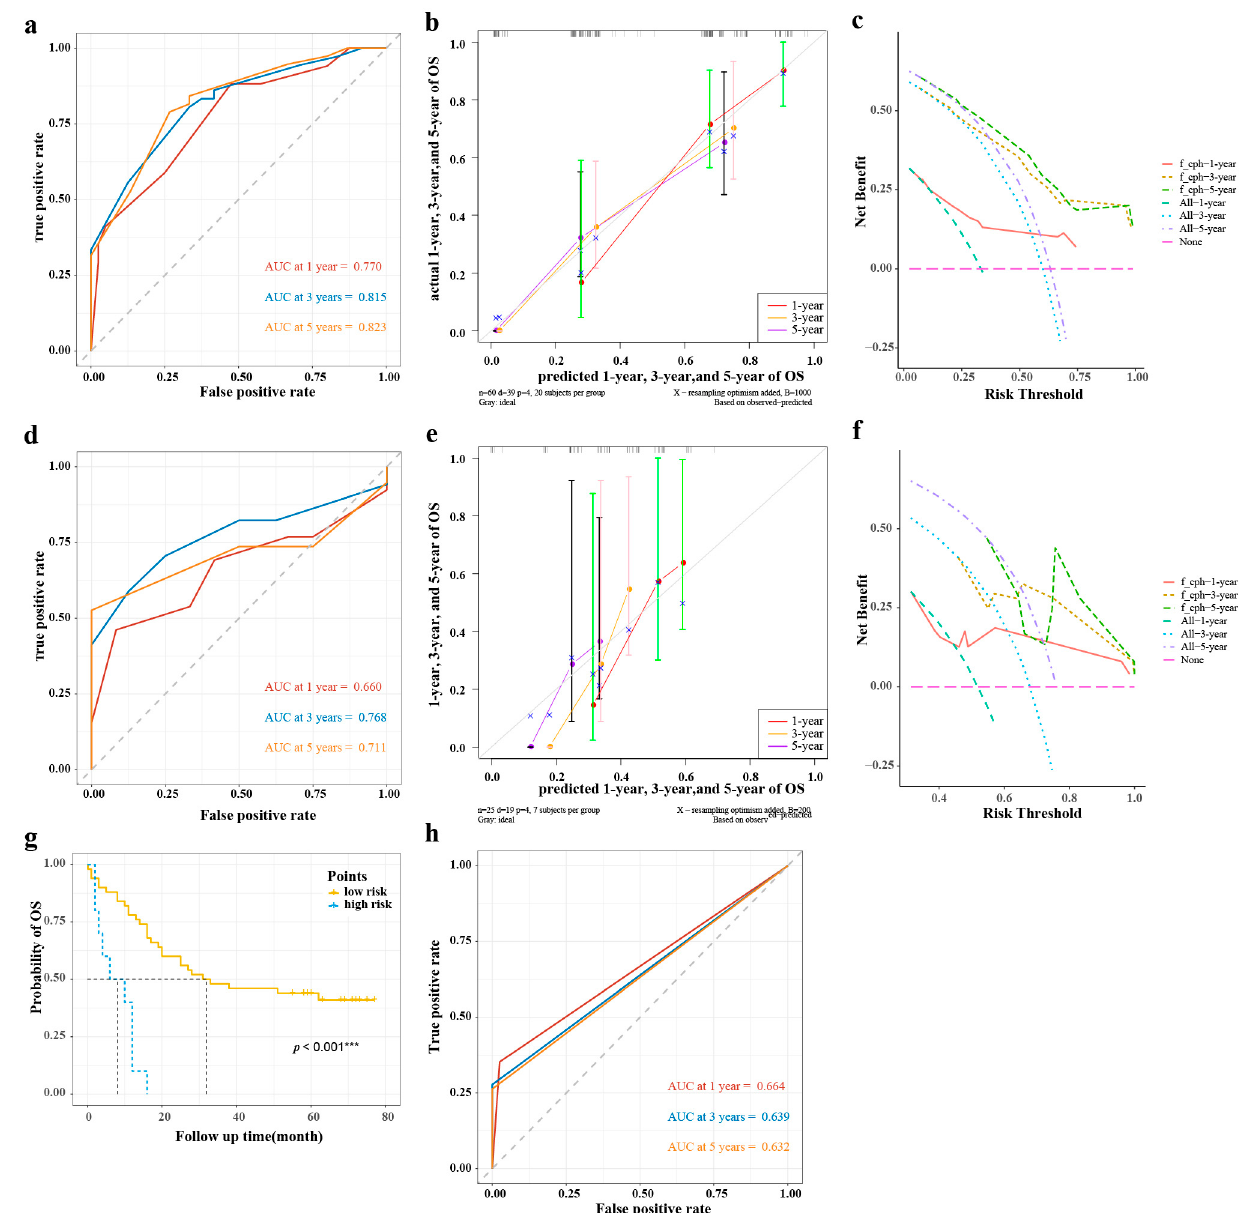
Figure 5. The validations of nomogram model and risk stratification of ESCC. ( a , d ) The AUCs at 1, 3, and 5 years of the training group and validation group; ( b , e ) The calibration curves at 1, 3, and 5 years of the training group and validation group; ( c , f ) The DCAs of the training group and validation group; ( g ) Survival curve analysis of risk stratification; ( h ) The AUCs at 1, 3, and 5 years of risk stratification in the training group. AUC, area under the curve of receiver operating characteristics (ROC); DCA, decision curve analysis; ESCC, esophageal squamous cell carcinoma; OS, overall survival. *** p < 0.001.